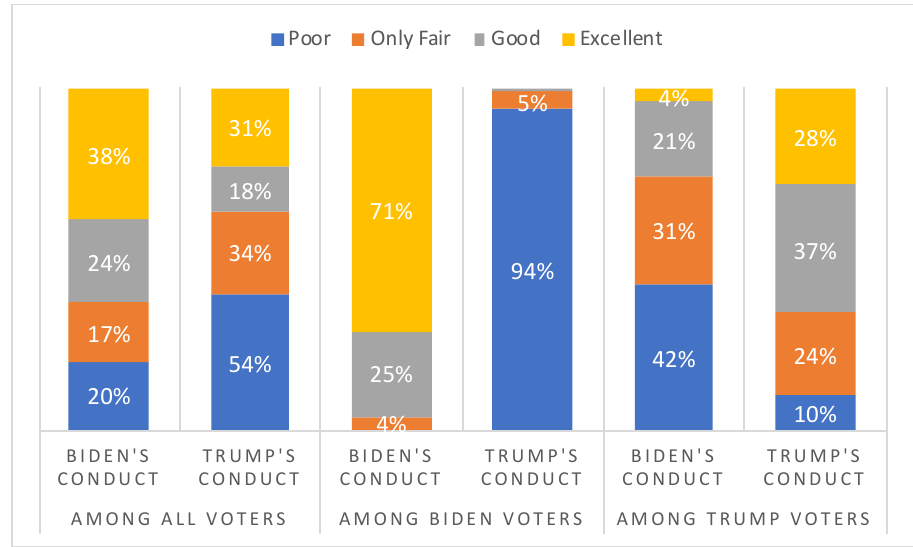
Figure 3. Trump and Biden’s post-election conduct evaluation. Source: Own elaboration from Pew Research’s American Trend Panel (2020).